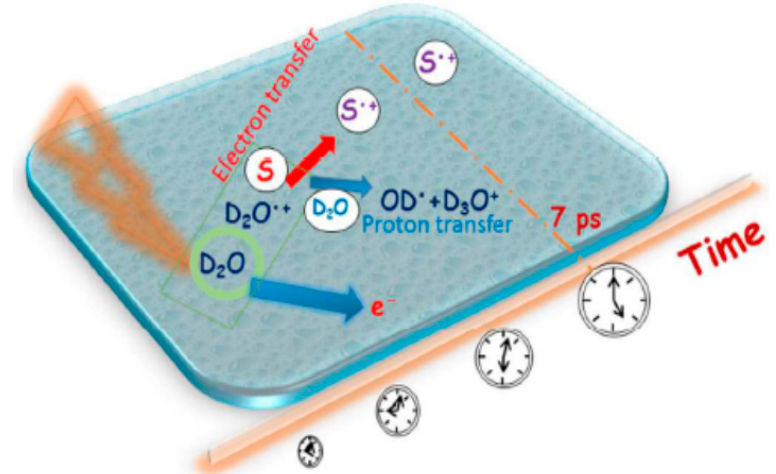
Figure 35. Schematic of the probing of the competition reactions of the radical cation D 2 O + • . A time resolution of 7 ps was used in the setup for probing the sulfate radical in deuterated sulfuric acid solutions. Figure adapted from [136] with permission. Copyright 2017 The Royal Society of